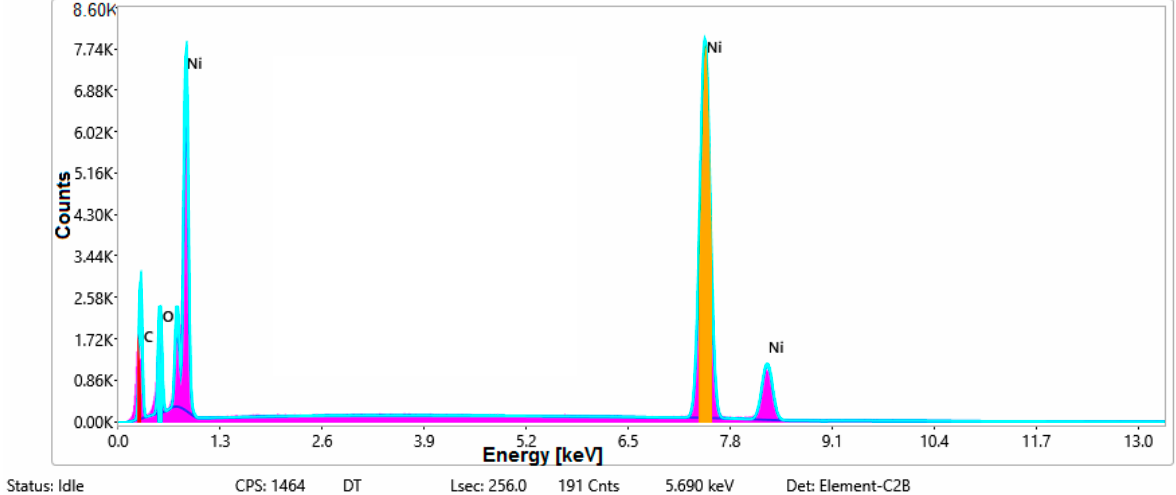
Materials 2021 , 14 , x FOR PEER REVIEW Figure 13. Smart elemental mapping overlay for sample S2 treated in RF plasma O 2 , using RF 1 generator and power 200 W.